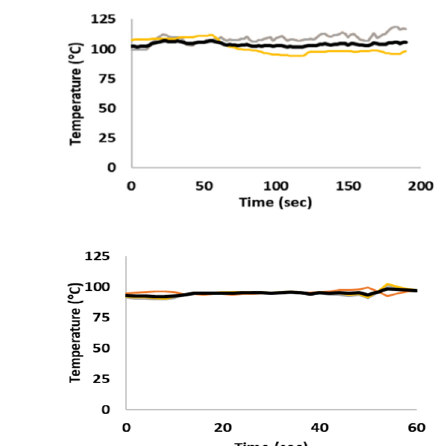
Figure 13. Electric resistance band used as a heating system. The surface temperature has been monitored with three type “K” thermocouples. A number of compression tests have been executed with an austenite SMA spring whose geometrical characteristics have been taken into account in the analytical model.